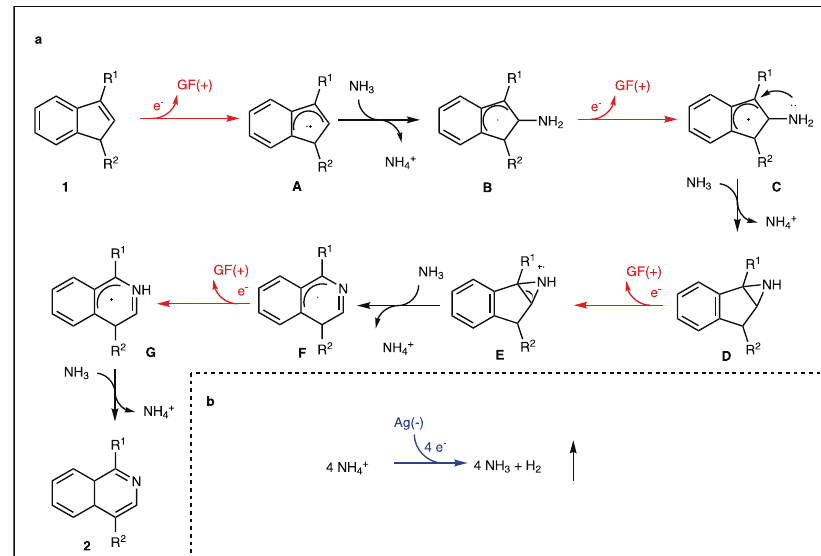
Fig. 5 A plausible reaction pathway involving 4e oxidation. a Anodic reactions converting substrate 1 to product 2 , GF( + ) is graphite felt anode. b Cathodic hydrogen